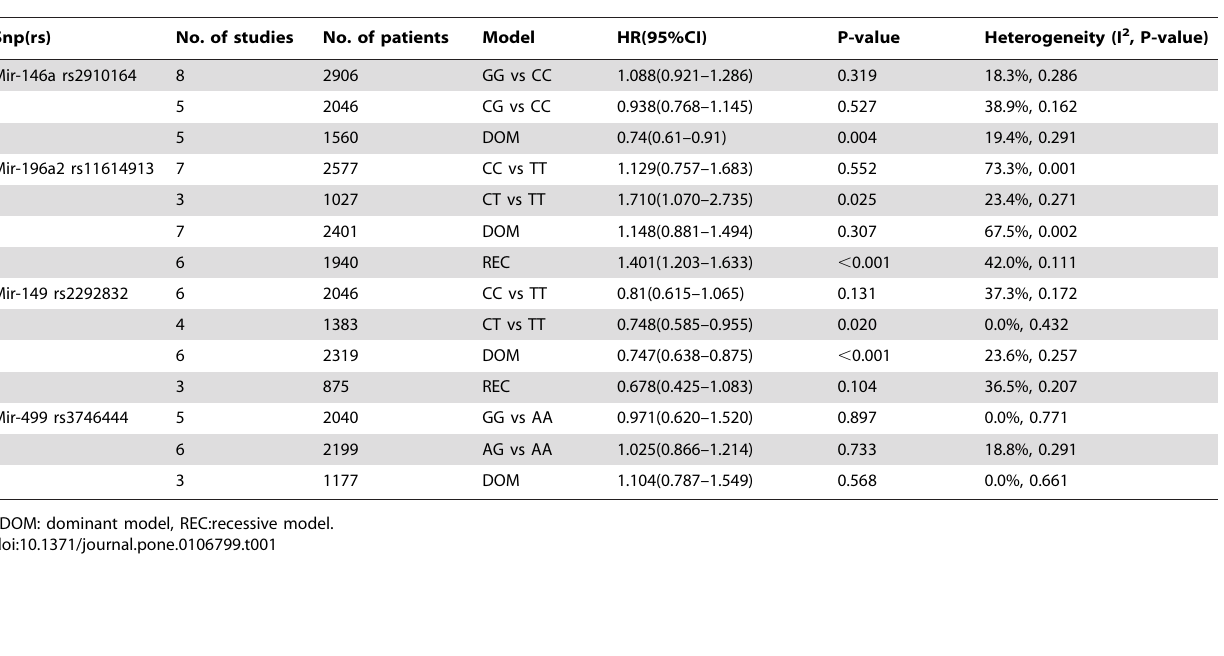
Table 1. Pooled HRs and 95%CIs from meta-analysis for